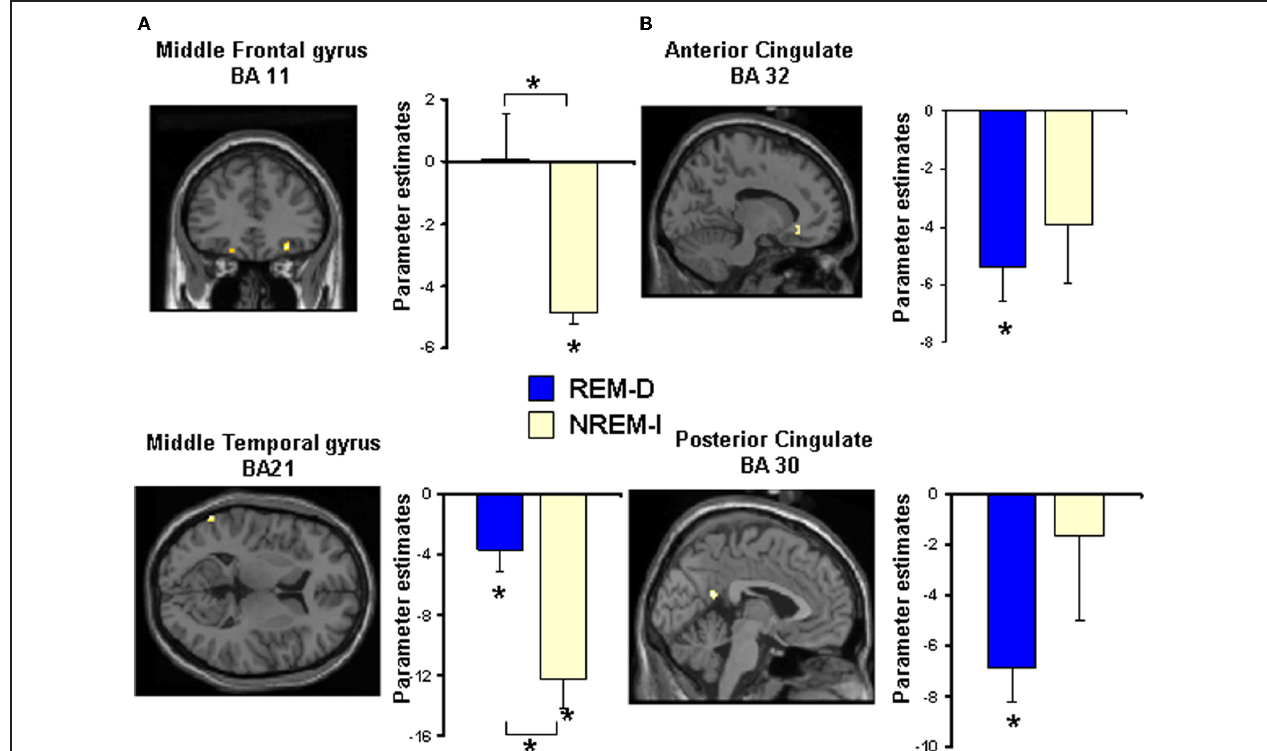
show the corresponding differences in activation between baseline and experimental night for the REM sleep deprivation and non-REM sleep interruption groups. Coordinates are in MNI space. Asterisks above brackets indicate significant post-hoc differences between groups whereas asterisks above individual bars represent significant differences from zero ( p < 0 .